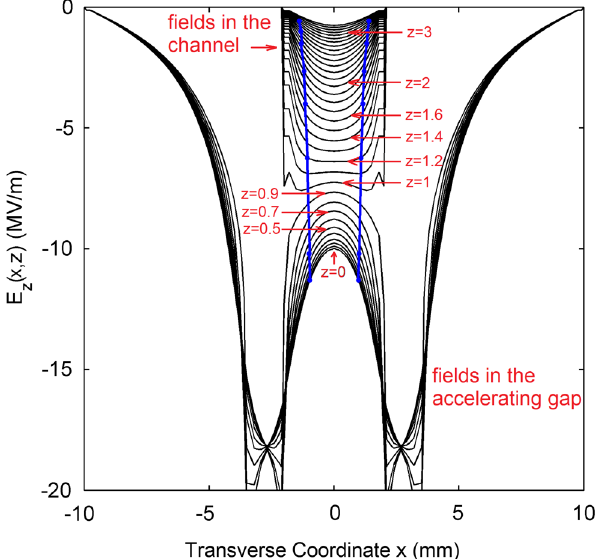
FIG. 7. A family of curves (black) of the longitudinal electric ð x; z Þ for different z as a function of x . The field is shown field E z in the cross section orthogonal to the conductors of the stripline- loop and drawn through the cathode, see the upper drawing in Fig. 3. For z < 1 the field extends over the region from − 10 mm to 10 mm, which corresponds to the interior space of the stripline- loop, whereas for z ≥ 1 the field is limited to the space inside the aperture channel. The blue curves depict the envelope of the electron beam.